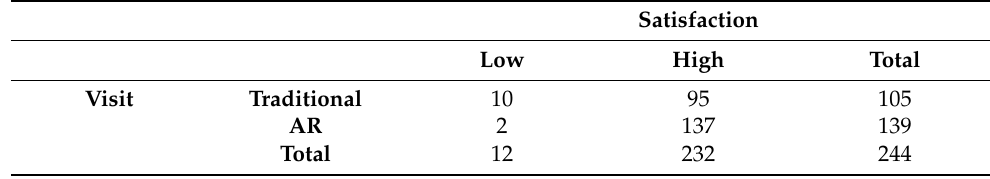
Table 1. Contingency table. Distribution of satisfaction by kind of visit. The table shows the number of participants who reported high satisfaction (satisfaction level greater or equal to 3) and who reported low satisfaction (satisfaction level less than 3) for each type of visit (traditional/AR)..